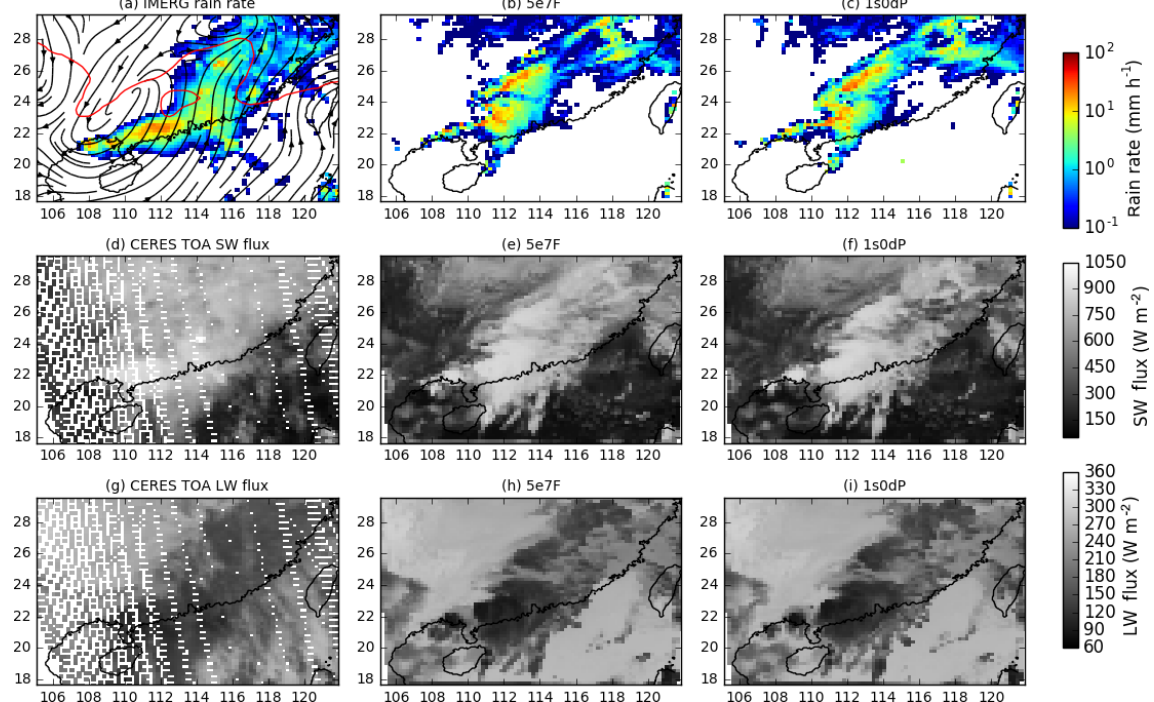
Figure 1. Surface-rainfall rates (a–c) , outgoing top-of-atmosphere short-wave (d–f) and long-wave (g–i) flux in GPM IMERG (a) , CERES- SSF (d, g) , and simulations with the 5e7F (b, e, h) and 1s0dP (c, f, i) configurations. The black streamlines and red contour in (a) show the 850hPa velocity field and the 315K contour of equivalent potential temperature, respectively, in the ERA (European Centre for Medium- Range Weather Forecasts – ECMWF – reanalysis) Interim reanalysis. The regional coastline is shown in black. All the fields shown are valid within at most 30min of 06:00UTC on 20 May